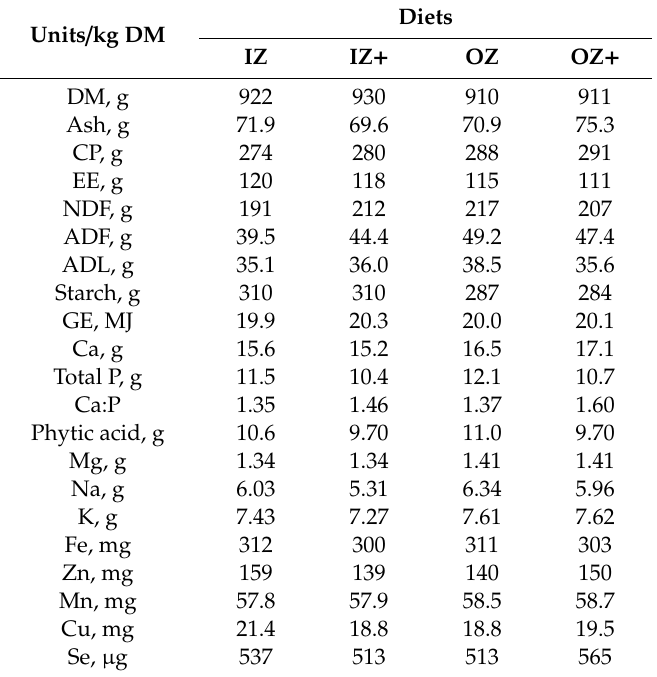
Table 3. Chemical composition of the experimental diets.